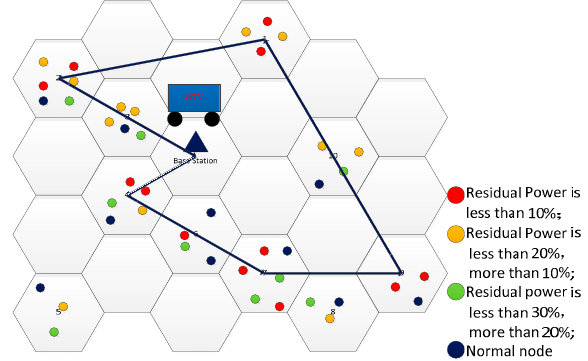
Figure 2. Diagram of the charging tour of the wireless charging vehicle (WCV).